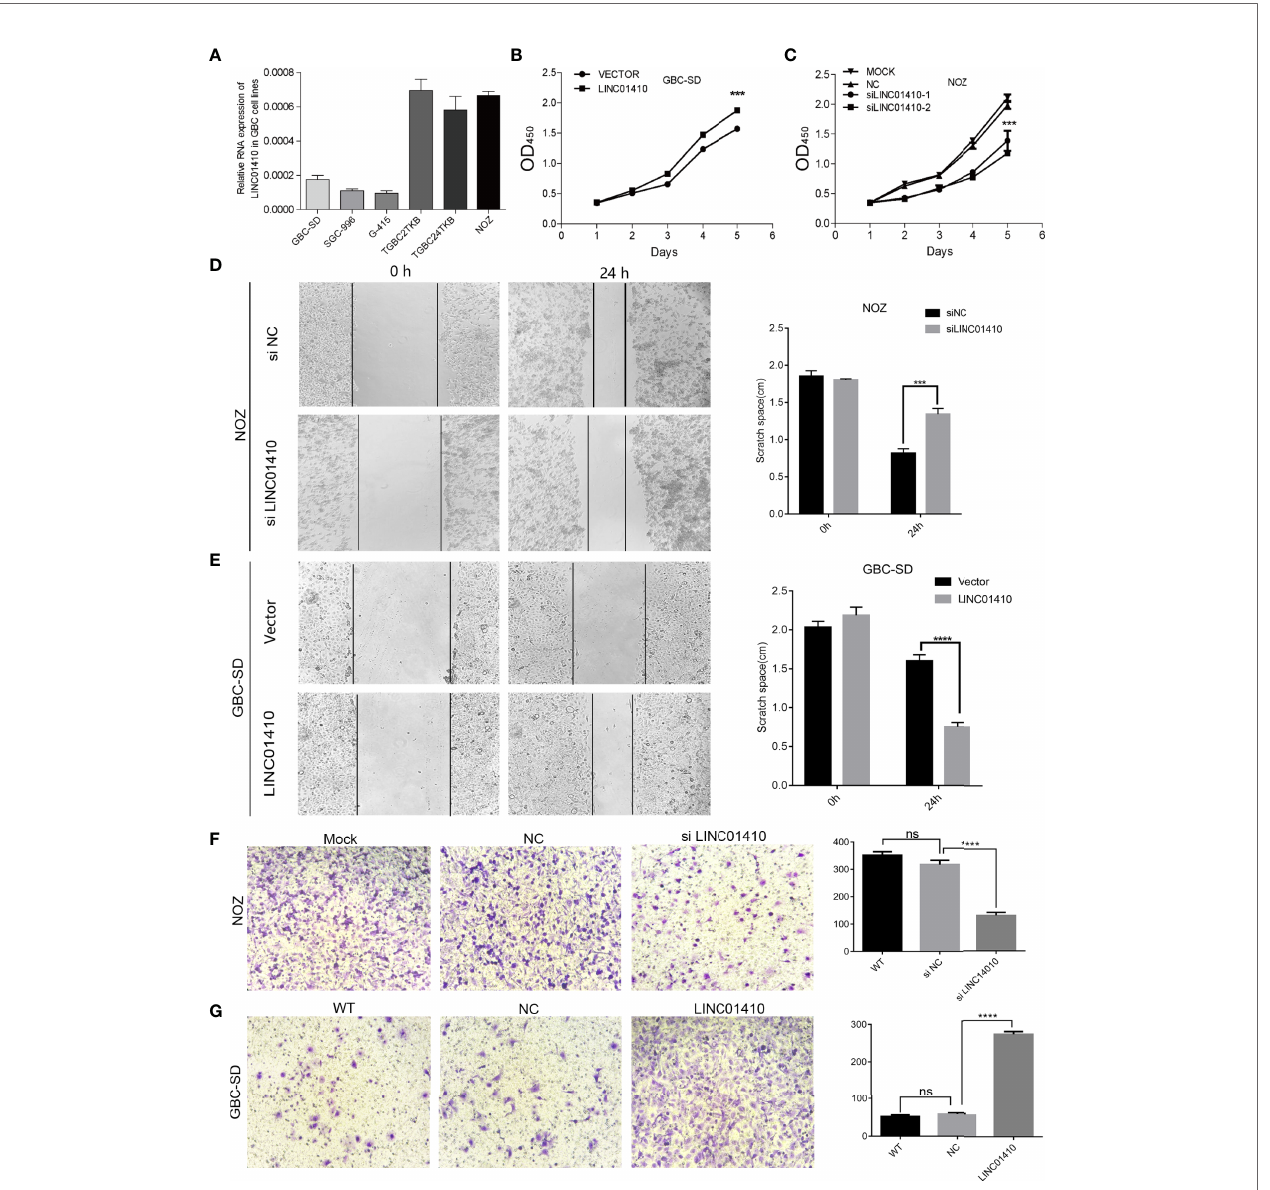
FIGURE 5 | LINC01410 promoted the development and progression of GBC in vitro . (A) qRT-PCR assay for LINC01410 expression levels in indicated GBC cell lines. (B, C) The effects of LINC01410 on cell proliferation were determined using CCK-8 assay. (D, E) The effects of LINC01410 on cell migration capability by wound healing assay. (F, G) Transwell assays were performed to determine the role of LINC01410 in the migration of GBC cells. Representative images of cell migration and statistical analysis of speci fi c migrated cell number were shown. Scale bar, 100 m m. ***p < 0.001; ****p < 0.0001; ns, not signi fi